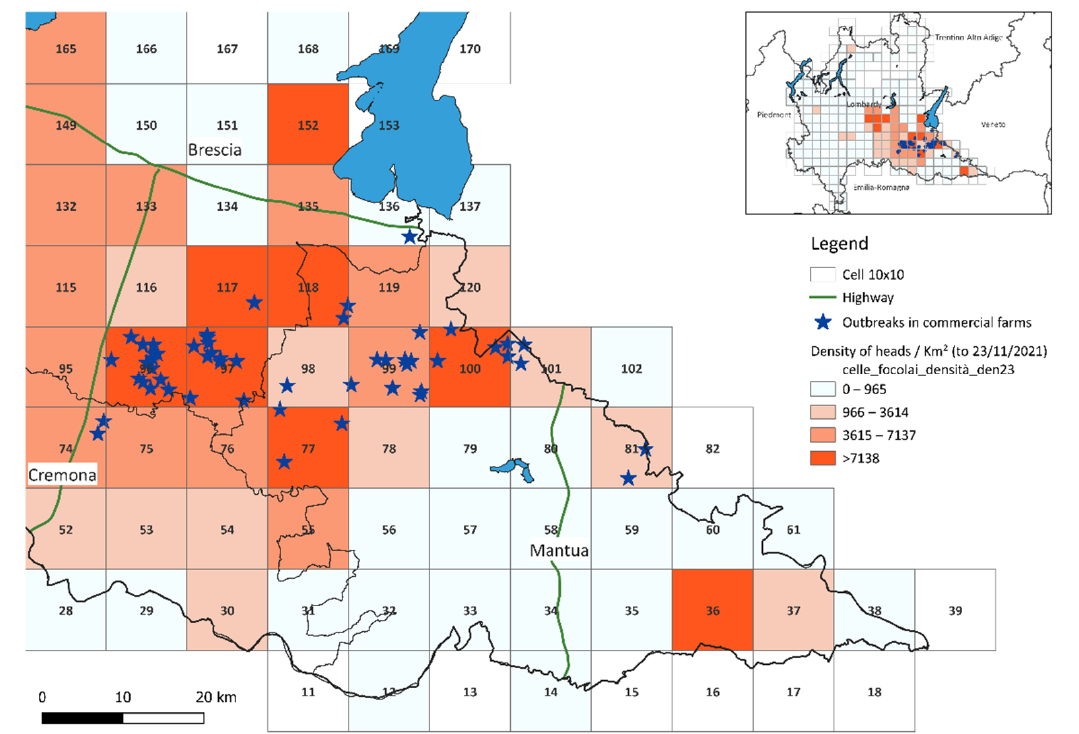
Figure 5. Map of avian influenza outbreaks and 10 × 10 km cells highlighted according to the density of birds per km 2 . Table 5. Results of the statistical tests of the density classes of the birds per km 2 as of 23 November